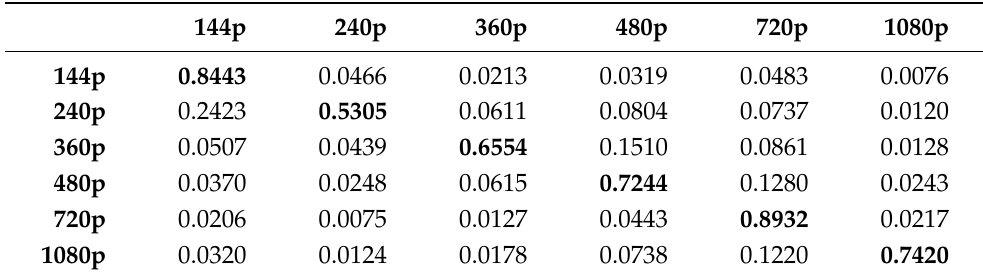
Table 13. Quality prediction—uplink feature